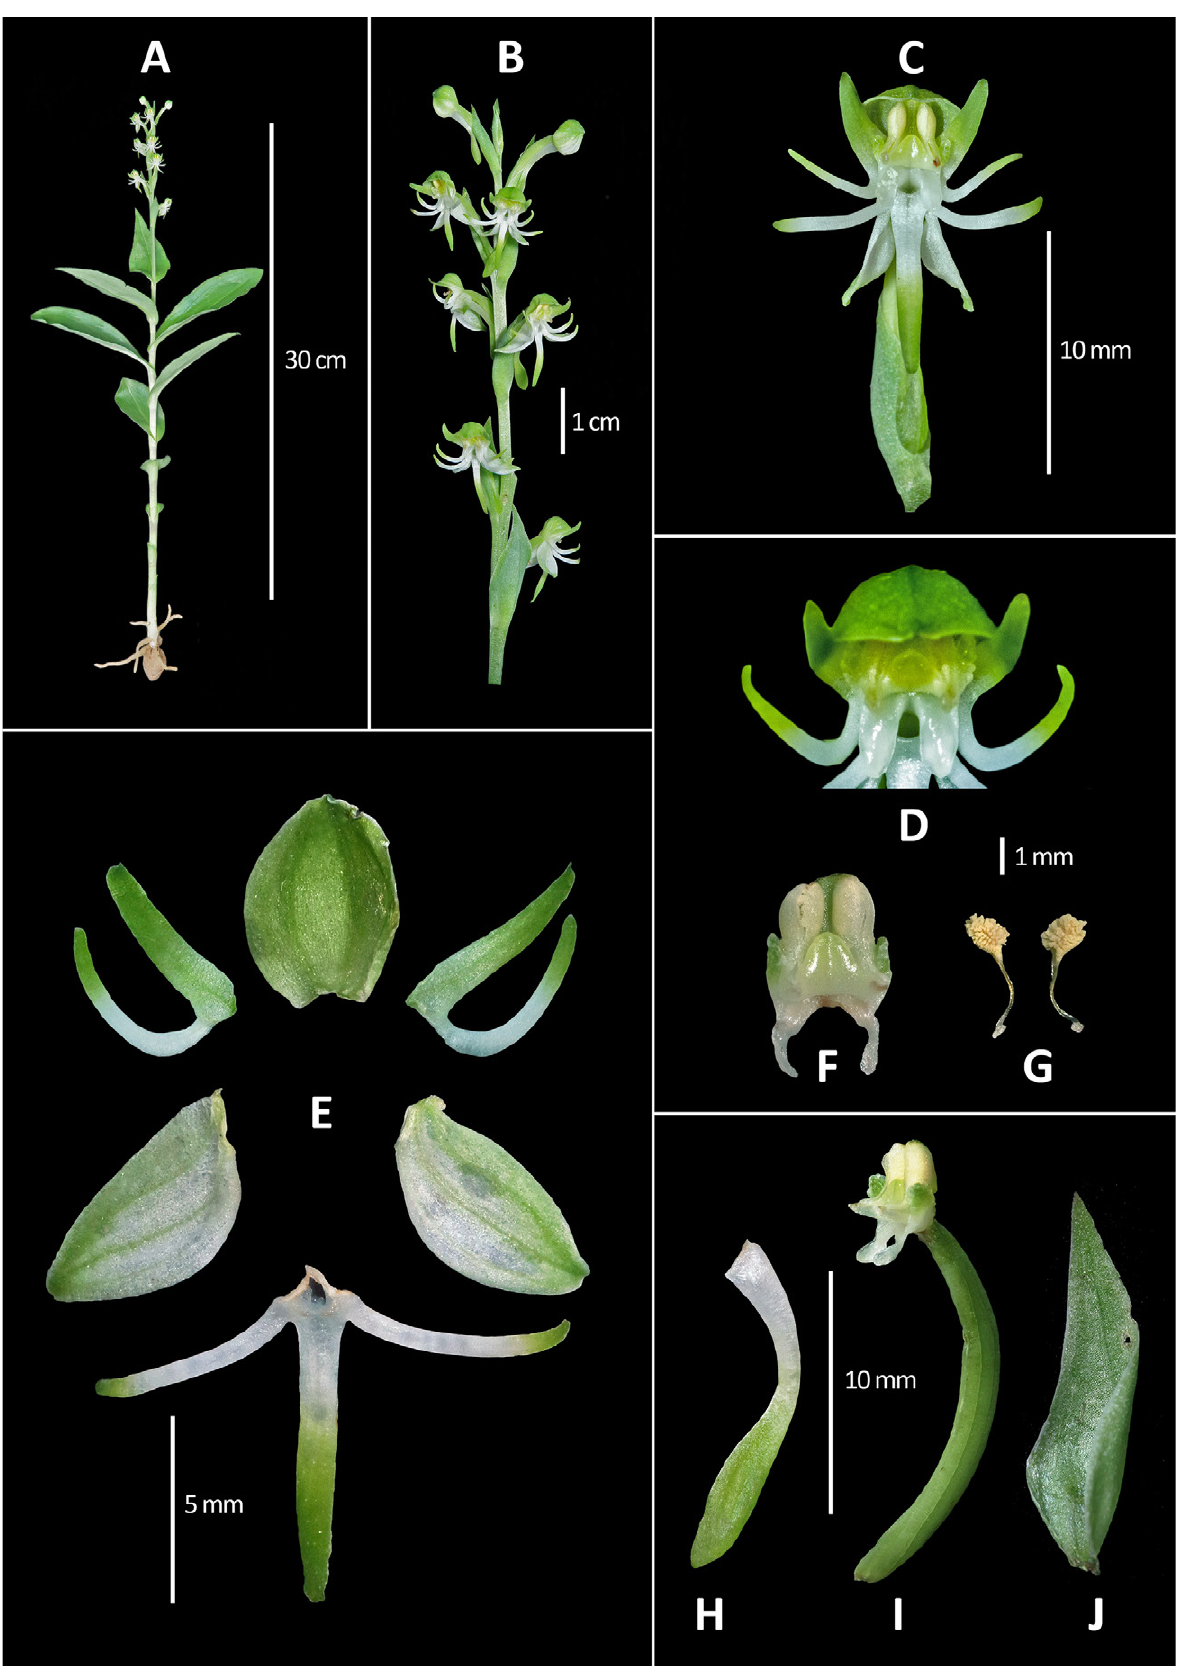
Figure 1. Habenaria gibsonii var. foetida . A . Habit. B. Inflorescence. C . Flower, frontal view. D. Stigmatic processes, frontal view. E. Dis- sected perianth, frontal view. F . Column and stigmatic processes, frontal view. G . Pollinaria, frontal view. H. Spur, side view. I. Ovary plus pedicel, column and stigma lobes, side view. J. Bract, frontal